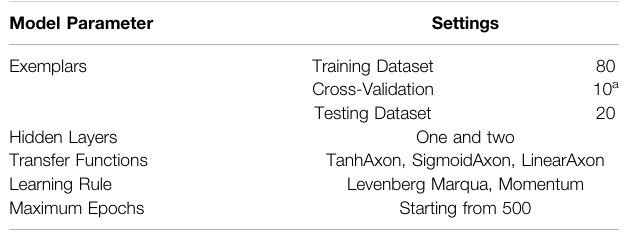
TABLE 2 | ANNs model setup.